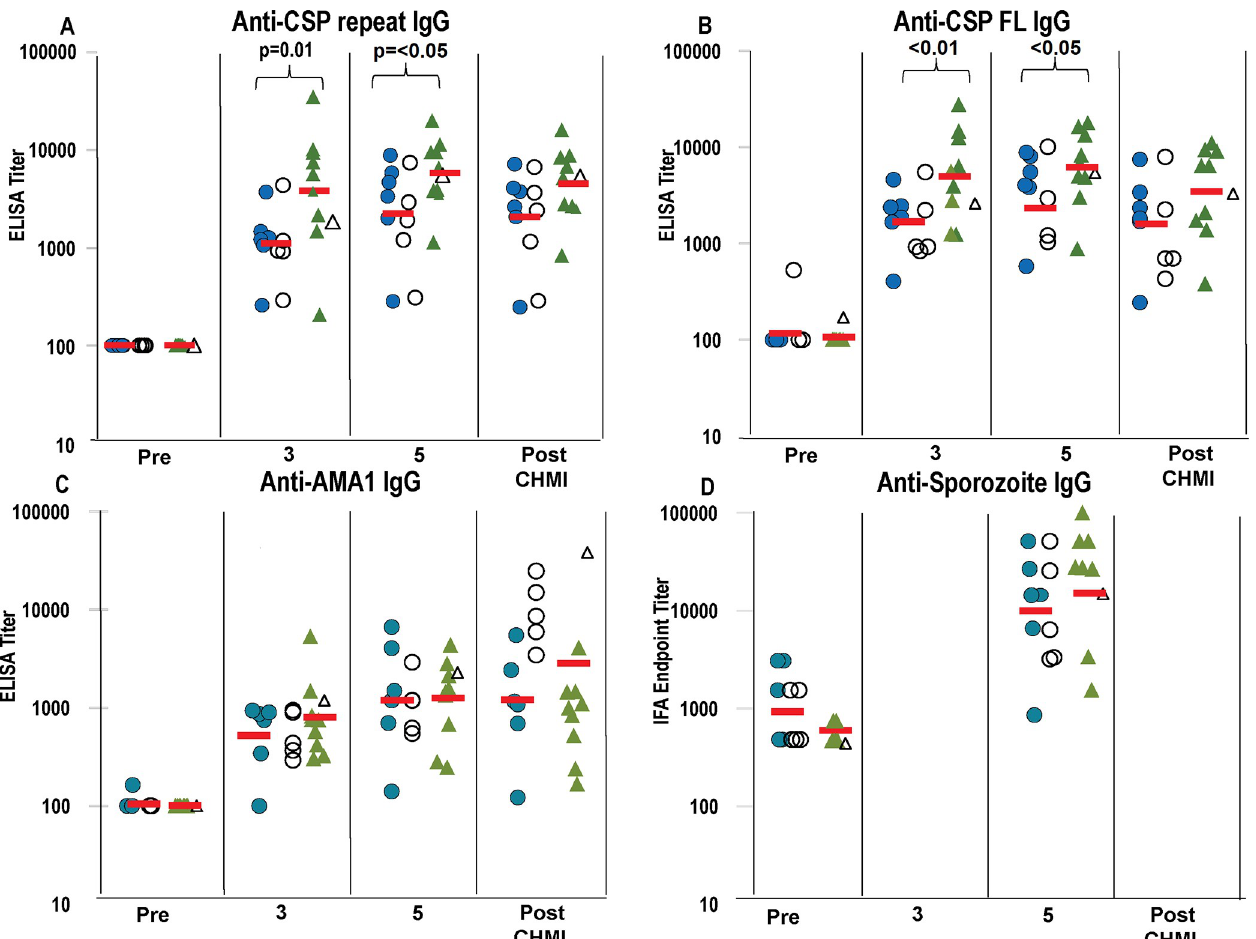
Fig 7. Cohort 1 and Cohort 2: ELISA activities after third and fifth immunizations and CHMI, and IFA activities after fifth immunization and CHMI. ELISA activities to CSP repeat, CSP full length (FL) and AMA1 of Cohort 1 (blue circles) and Cohort 2 (green triangles) were measured pre-immunization (Pre), 14 days after the third (3) and 22 days after fifth (5) immunizations and 28 days after CHMI (Post-CHMI). IFA activities to sporozoites were measured pre-immunization (Pre), and 22 days after fifth (5) immunizations / pre-CHMI. Protected subjects (closed symbols) and non-protected subjects (open symbols). The Geometric mean (red bar) is shown for all subjects in each Cohort. Panel A: CSP repeat : Geometric mean activities in both Cohorts significantly rose after the third and fifth immunizations (see text). Activities in Cohort 2 were significantly higher than Cohort 1 after the third and fifth immunizations. Panel B: CSP Full Length (FL): activities were similar to those with CSP repeat and activities of Cohort 2 were only significantly higher than Cohort 1 after the third and fifth immunizations. Panel C: AMA1 : Geometric mean activities of Cohort 1 and Cohort 2 significantly rose after the third and fifth immunization (see text) but were not different between Cohort 1 and Cohort 2. Panel D IFA : Activities of Cohort 1 and Cohort 2 significantly rose after the fifth immunizations (see text) but were similar in Cohort 1 and Cohort